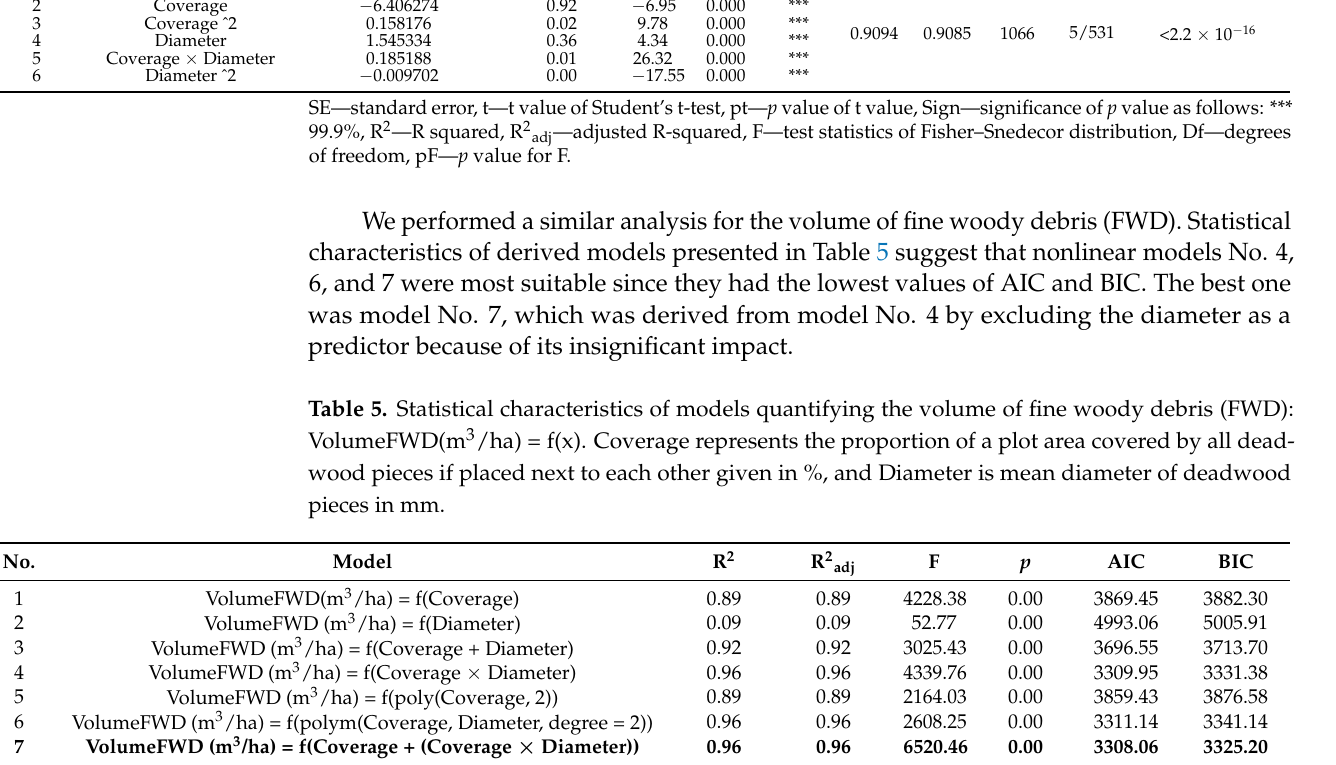
Legend: R 2 —coefficient of determination, R 2 adj —adjusted coefficient of determination, F—test statistics of Fisher– Snedecor distribution, p —critical p value of F statistics, AIC—Akaike information criterion, BIC—Bayesian information